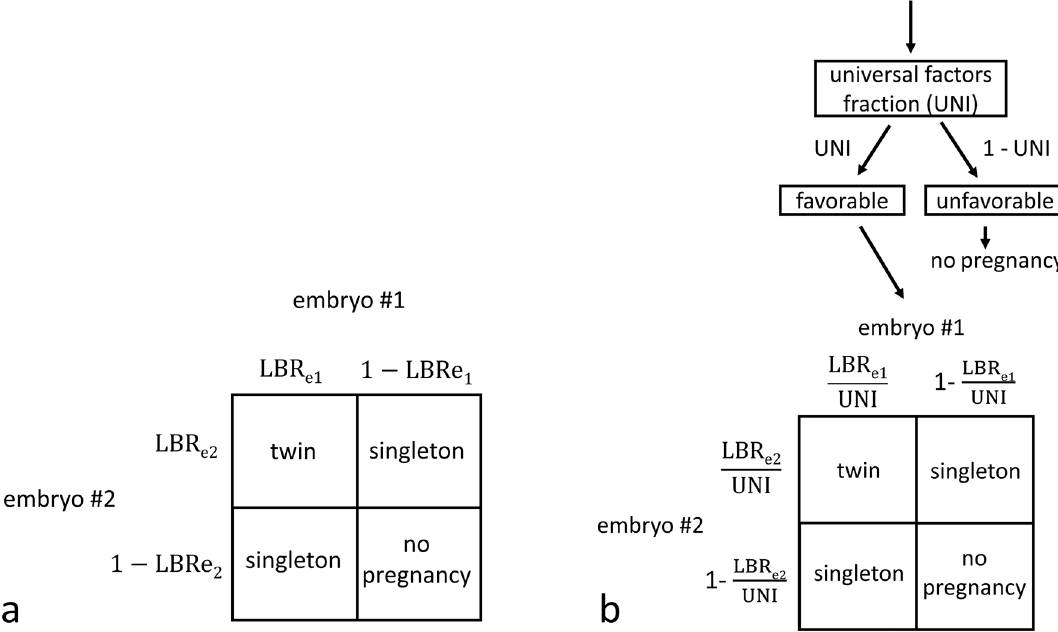
Figure 2. Embryo transfer models demonstrated for transfer of two embryos. ( a ) Demonstrates logic for independent embryo implantation and ( b ) demonstrates logic for independent embryo implantation only when universal factors are favorable. The universal factors fraction is a fraction from 0 (never favorable) to 1 (always favorable). The probability of each outcome is equal to the product of the terms next to the corresponding arrows above and the corresponding terms on the perimeter of the square. For example, the predicted LBRe1 LBRe2 probability of twins in panel b is UNI × UNI × UNI . This same logic can be applied to transfer of more than two embryos. UNI, universal factors fraction; LBR e1 , live birth rate for embryo 1; LBR e2 , live birth rate for embryo 2. This figure is being reproduced from a previous publication 19